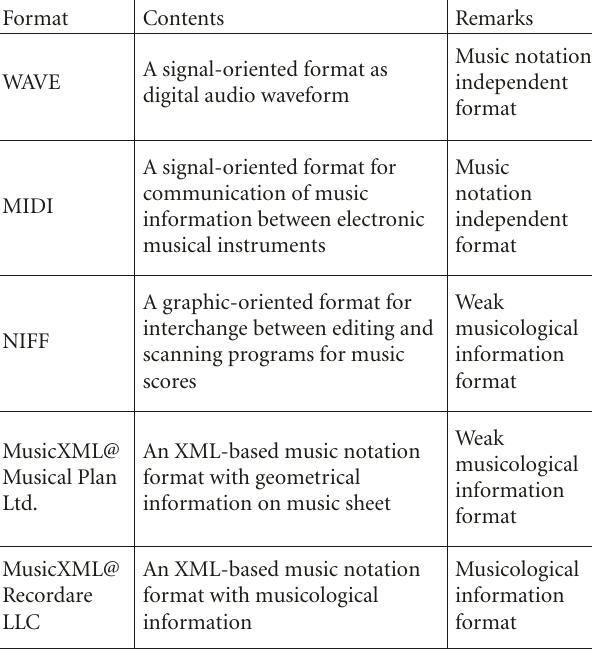
Table 3: Computer-based musical